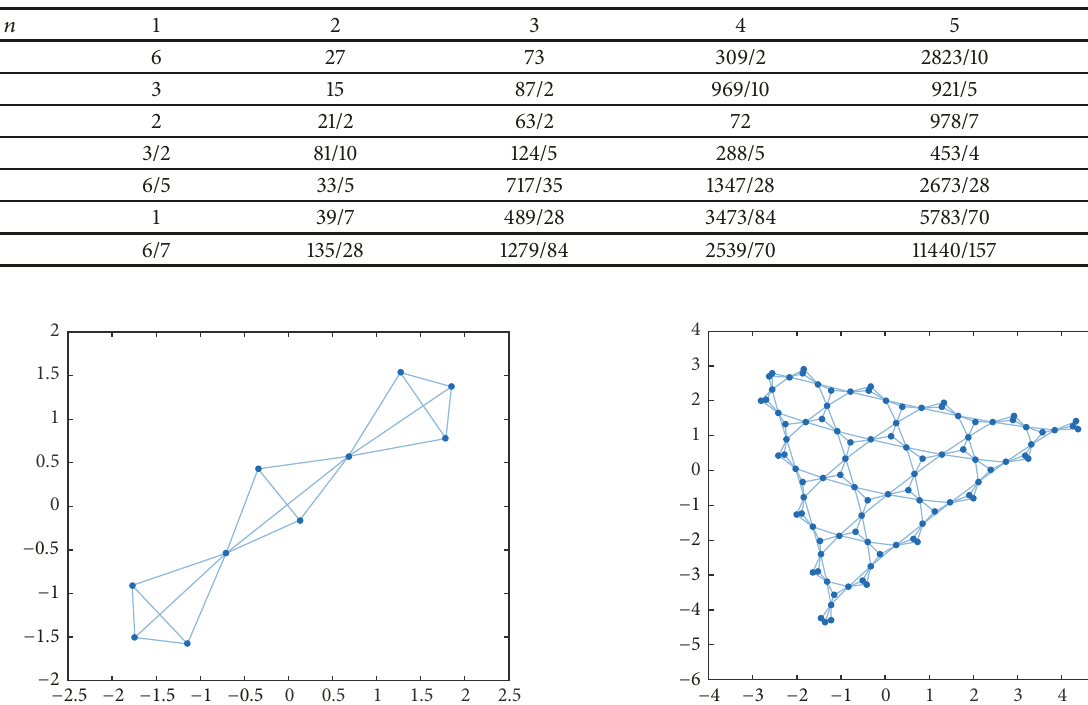
Table 9: Generalized Harary index of 𝑇𝑂𝑋 .